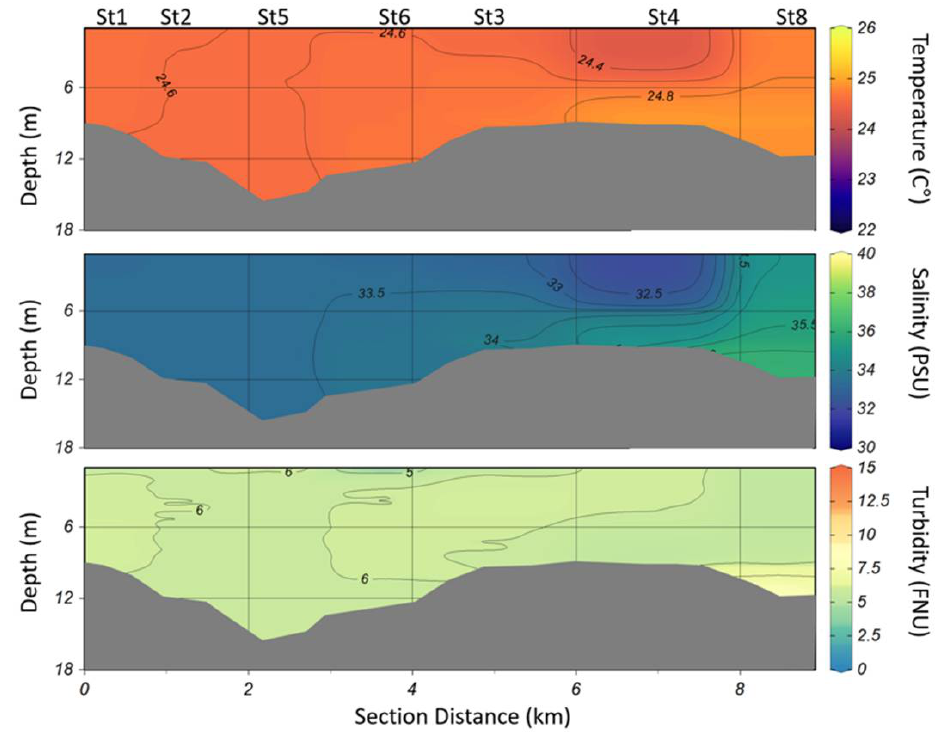
Figure 12. Representations of CTD casts (temperature, salinity and turbidity) along the lagoon–sea transect (white dotted line in Figure 1) on 15 September 2020. Plot generated with Ocean Data View software (https://odv.awi.de, 2021 accessed on 12 July 2022).